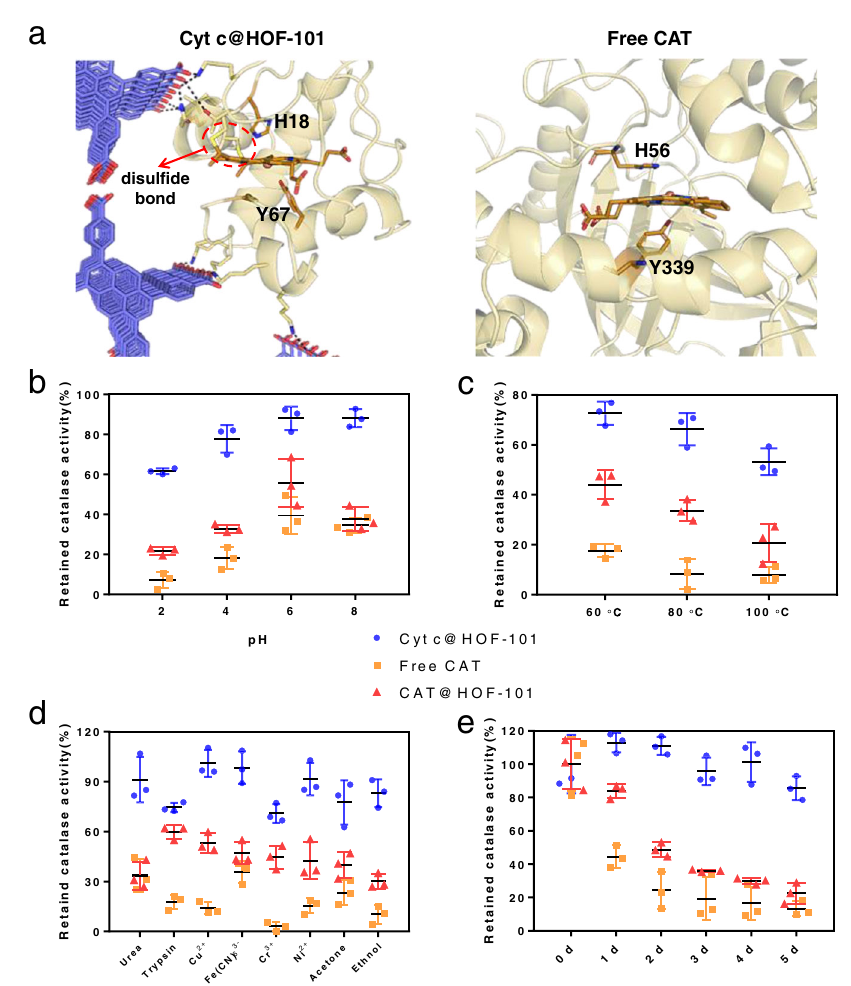
d Enzymes or biocomposites were exposed in different solutions at room tem- perature for 30min. Urea: 6mol/L; Trypsin: 5mg/mL; All of the metal ions: 10mmol/L; Organic solvents: 80% (v/v). The fi nal H 2 O 2 concentration used in the activity test was 10mM. e The evaluation of the storage stability of native CAT, CAT@HOF-101 and Cyt c@HOF-101 in terms of the variation of CAT-like activity. Enzymes or biocomposites were dispersed in pH=7 deionized water, and then stood at 35°C for different periods. The fi nal H 2 O 2 concentration used in the activity test was 10mM. In b – e , the symbols of blue circle, orange square, red triangle represent Cyt c@HOF-101, free CAT and CAT@HOF-101, respectively. The data of 3 independent samples and calculated error bars (SD) are presented